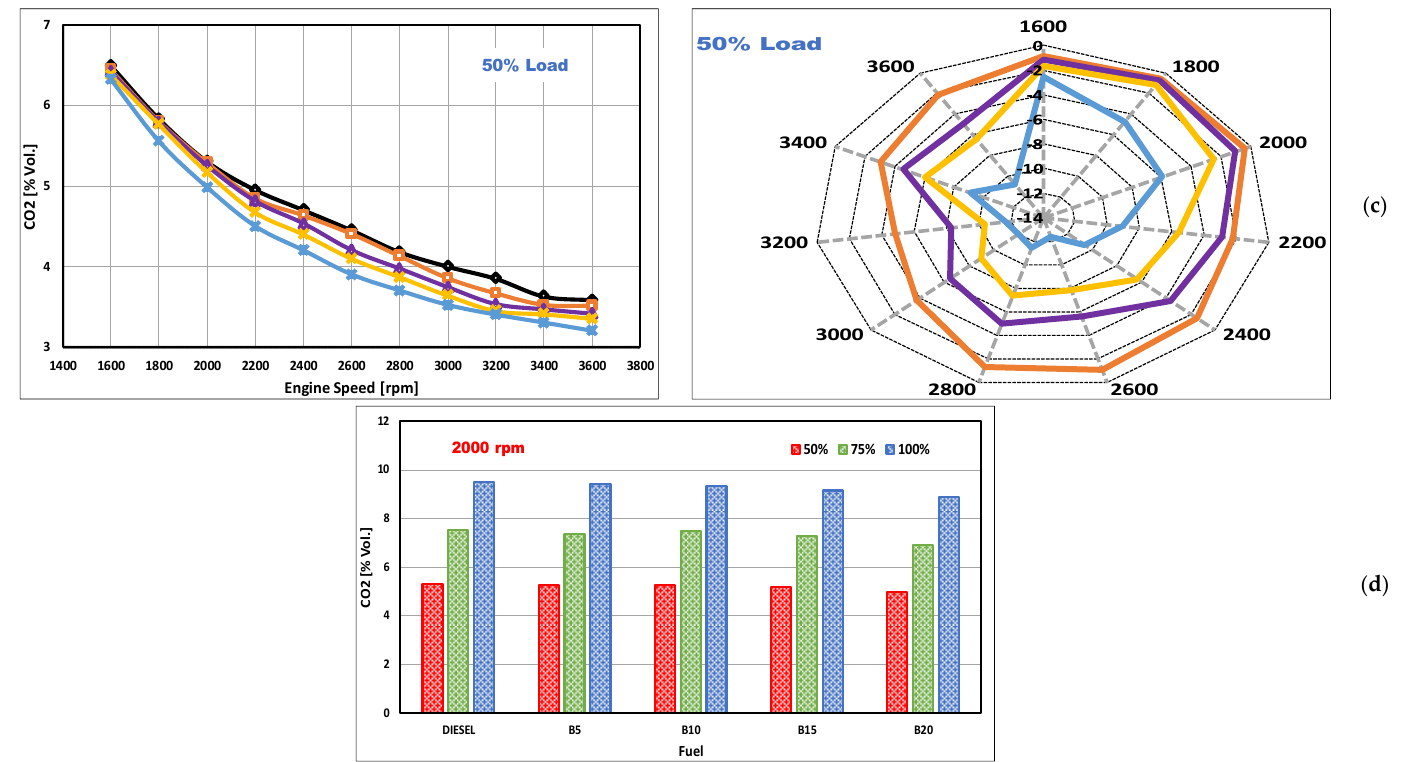
Figure 3. CO 2 variations with engine speed and load, presented as trends (left) and the normalized value contours (right) for ( a ) 100%, ( b ) 75%, and ( c ) 50% loading. ( d ) Comparison of the results for all fuels at all loads at 2000 rpm.